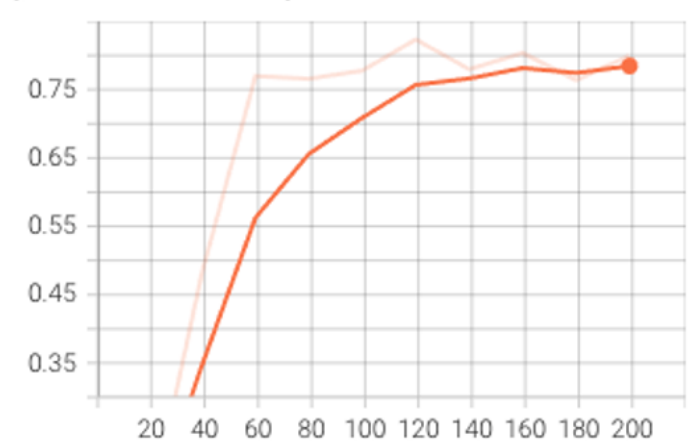
Figure 12. Training accuracy capping at 76% for Faster-RCNN with 50